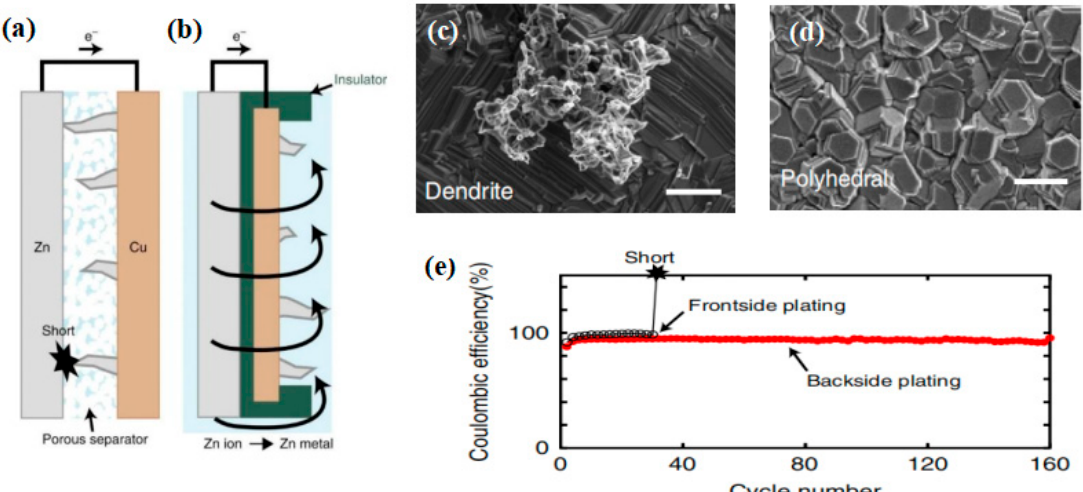
Figure 9. Schematic illustration: ( a ) frontside-plating configuration and ( b ) backside-plating configuration; SEM image (scale bars, 2 mm) of Cu substrate surface from the ( c ) frontside-plating and ( d ) backside-plating configurations after 20 cycles; ( e ) the cell stability curves compared the front with backside configurations (20 mA cm − 2 ). Reproduced under terms of the CC-BY license [97]. Copyright 2016, Springer Nature.